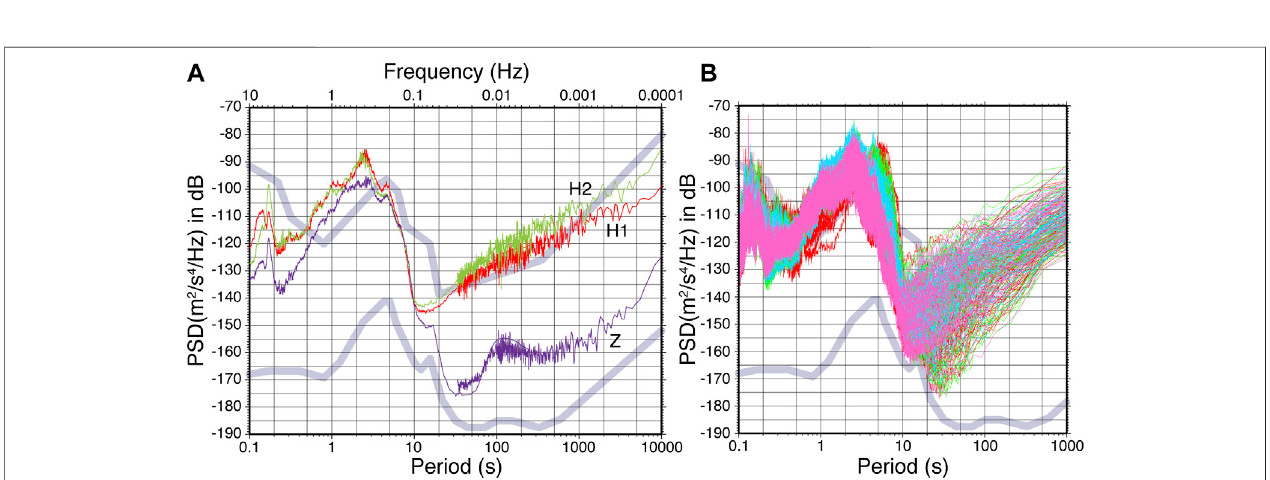
FIGURE 2 | Noise model of the BBOBS. (A) One example of the noise model (NM) of the BBOBS using the IRIS standard procedure, which indicates the observation performance of the site including the instrument. The vertical component NM (Z) is usually between the NHNM and the NLNM (thick curves), but horizontal ones (H1 and H2) are around or above the NHNM in the long period range, more than 30 s. (B) Stack of the noise spectra used to calculate the H1 component NM in Figure 2A . Colors indicate four seasons: cyan (January-March), pink (April-June), red (July-September), and green (October-December). Although the H1 ’ s NM is high, the lowest noise level could be near the NLNM in a 10 – 30 s